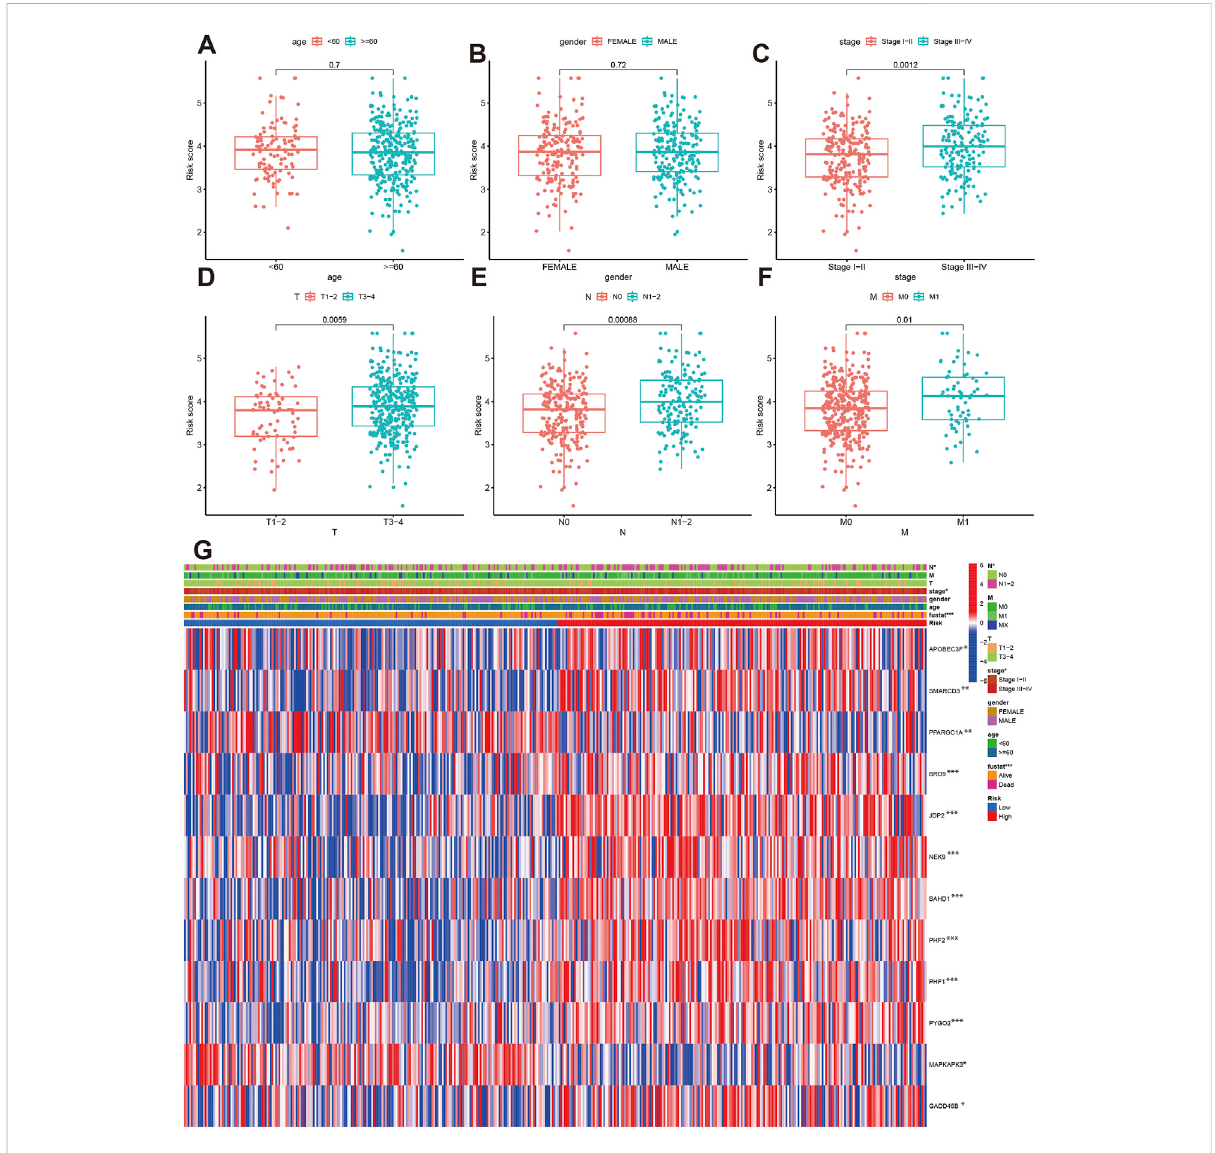
FIGURE 6 The correlation of risk score with clinical parameters. (A – F) Comparisons of risk score between different age, gender, stage, T, N and M classi fi cation. (G) The correlations of risk groups with clinical parameters and signature gene